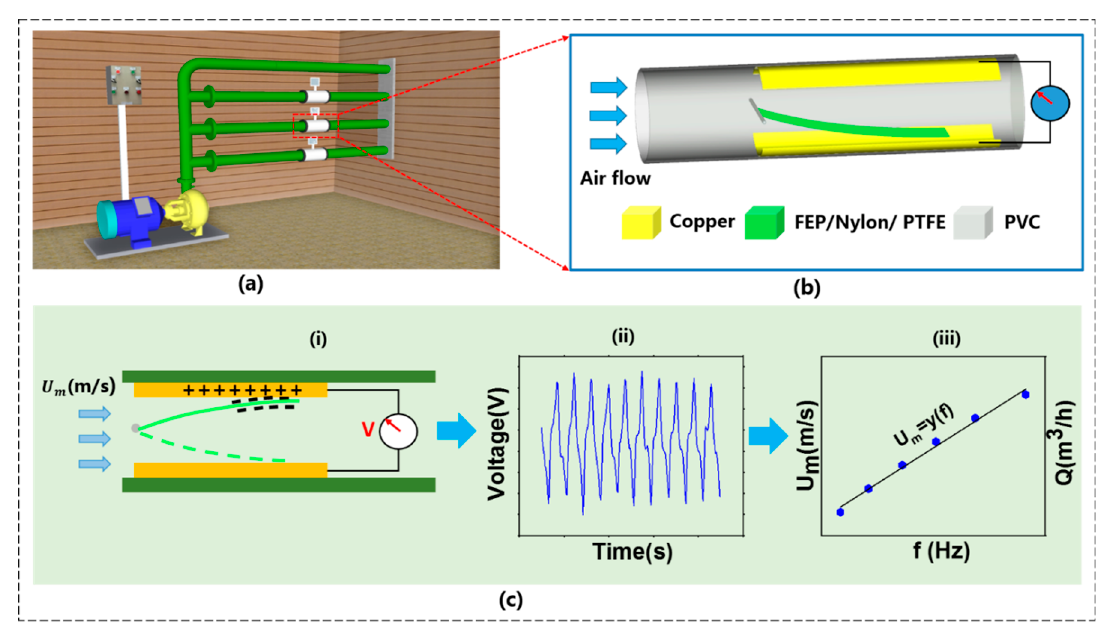
Figure 1. ( a ) Schematic diagram of the fabricated triboelectric nanogenerator (TENG) flowmeter for gas flow rate measurement, ( b ) TENG flowmeter structure, ( ci ) electric harvester principle of the TENG flowmeter, ( cii ) voltage output to time domain, ( ciii ) linear fitting relationship between frequency and gas flow velocity.